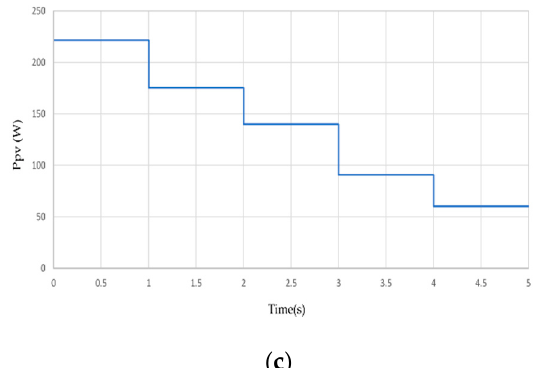
Figure 7. System output waveforms when irradiance is fixed at 1000 W/m 2 and temperature at 25 °C: ( a ) Power reserve ratio; ( b ) PV voltage; ( c ) PV output power. Case 2: Reserve ratio is kept constant at 50 W and irradiance is varied.